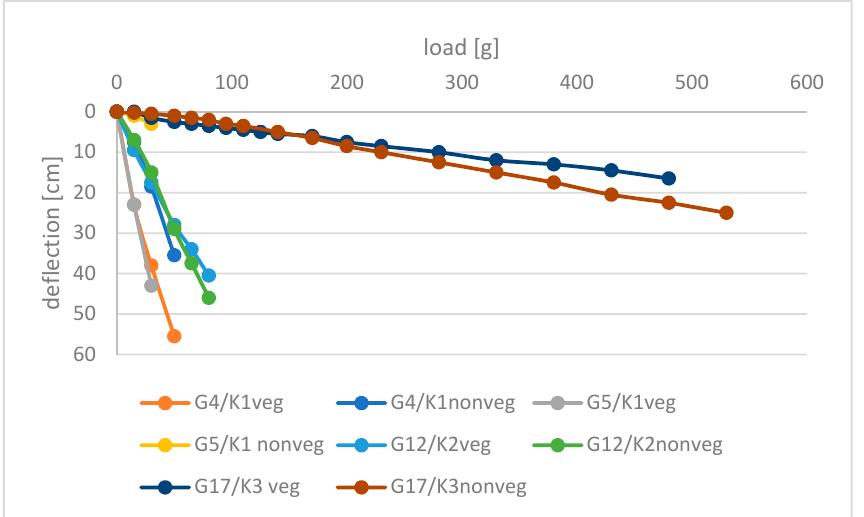
Figure 10. Figures of deflection arrows of selected branches of shrubs 1, 2, and 3, loaded at 100 cm above ground level (where Gx —branch number; Kx —shrub number).